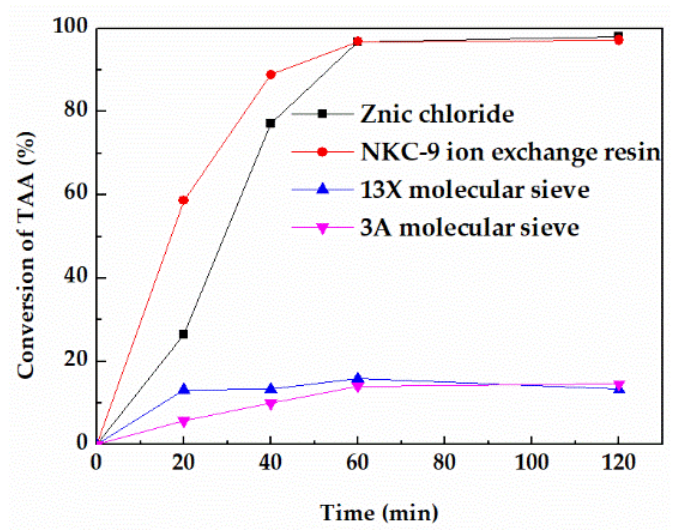
Figure 1. Effect of different catalysts on the conversion of TAA. The order of reaction activity is r (zinc chloride) ≈ r (NKC − 9) > r (3A molecular sieve) > r (13X) molecular sieve under the same conditions. Zinc chloride showed the highest